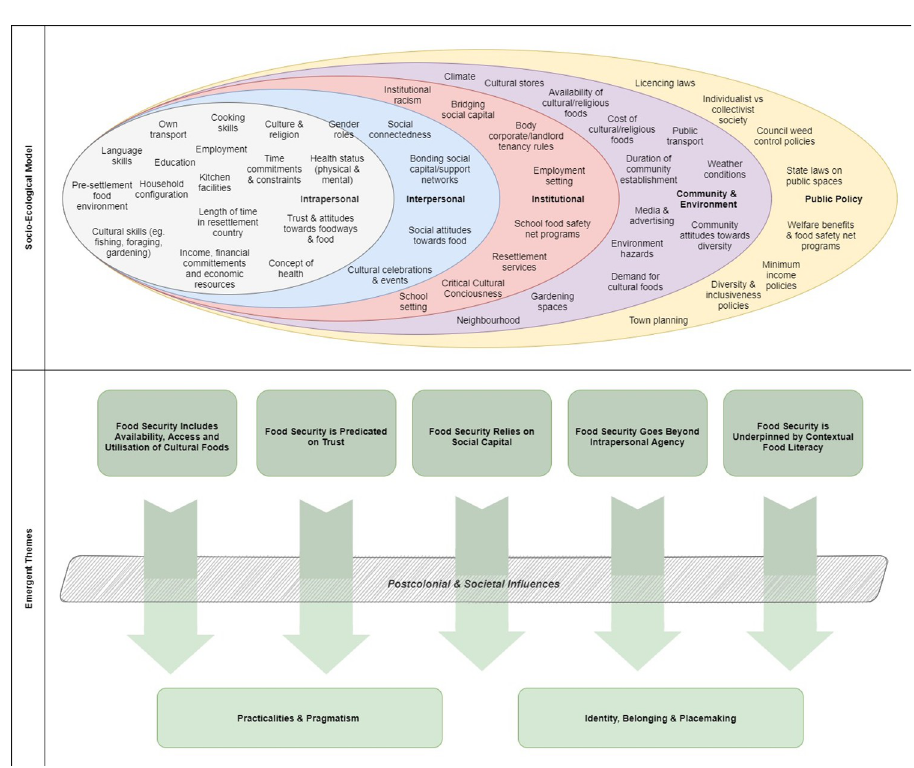
Fig 2. Graphical representation of findings from selected